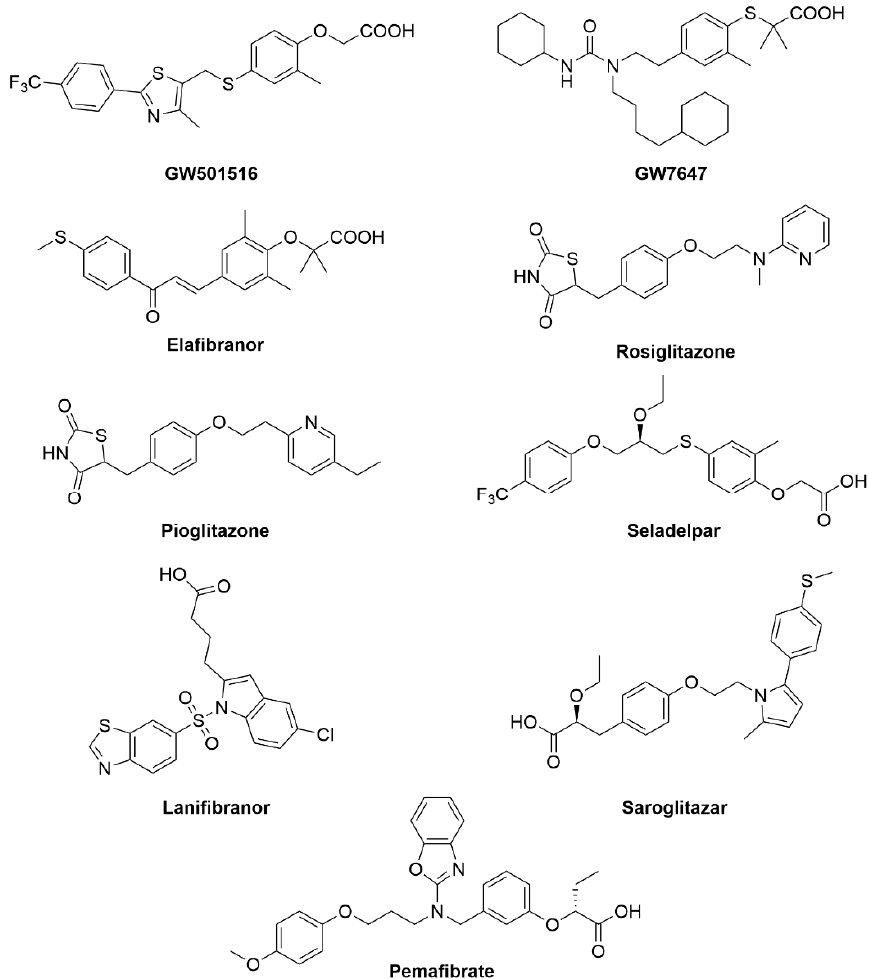
Figure 6. PPAR compounds that are currently in clinical trials or have approval for the treatment of NAFLD and related disorders.